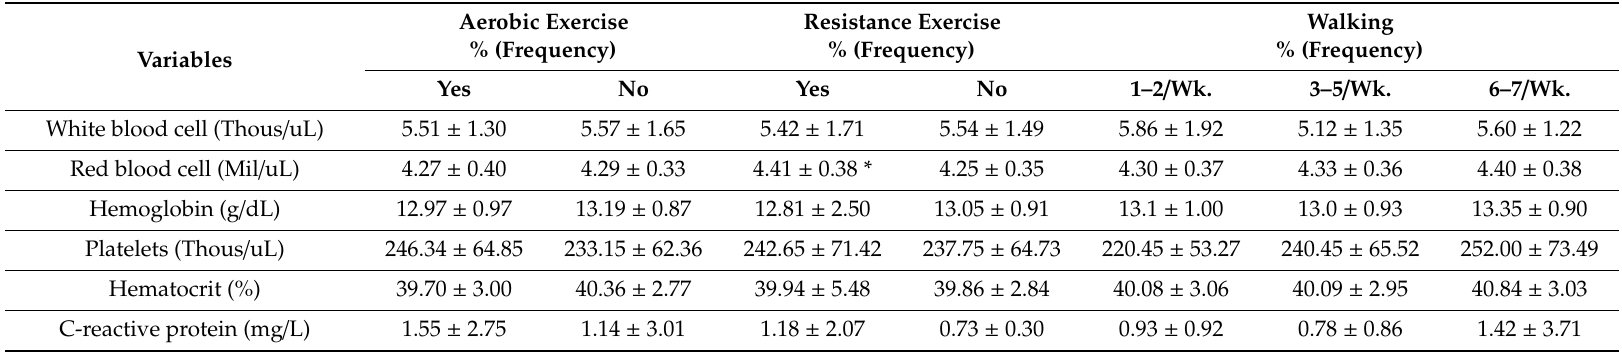
Table 4. Di ff erences between exercise modality participation in relation to hemodynamic variables in breast cancer survivors. Aerobic Exercise Resistance Exercise % (Frequency) Variables